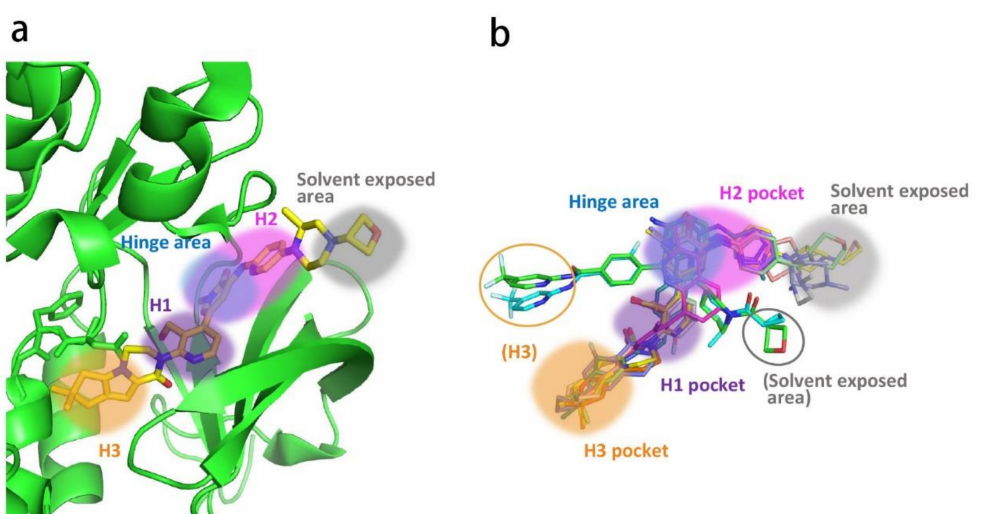
Figure 13. ( a ) The binding site of BTK complexed with fenebrutinib (PDB code: 5VFI) is depicted with key regions highlighted by different shaded colors. The binding site is indicated in the green cartoon representation. Fenebrutinib (34) is shown as sticks and the carbon atoms are depicted in yellow. Key areas for ligand binding, such as the H1 pocket (purple), H2 pocket (magenta), H3 pocket (orange), the solvent-exposed area (grey) and hinge area (light blue), are represented. ( b ) Superimposition of representative BTK inhibitors from crystallographic data within the binding site (Compound 2 , 24 , 25 , 28 , 30 , 31 , 32 , 33 , 34 , 35 ; PDB code: 3OCS, 5FBN, 5FBO, 4Z3V, 4OTF, 4RX5, 5P9G, 5VGO, 5VFI, 6W07). Inhibitors are shown as sticks in different colors. Key areas for ligand binding are highlighted as in ( a ). All structural images were created using PyMoL